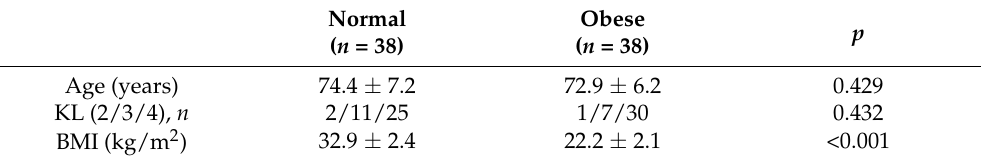
Figure 1. Expression of CPA3 and NMU / NMURs in the synovial membrane of normal-weight, overweight, and obese groups. The expression of NMU / NMURs and CPA3 mRNA in NW, OW, and OB groups was estimated by qPCR ( A – D ). NMU ( A ), NMUR1 ( B ), NMUR2 ( C ), and CPA3 ( D ) mRNA expression in the synovial membrane of normal-weight (NW, n = 79), overweight (OW, n = 87), and obese (OB, n = 40) patients with knee osteoarthritis. Gene expression is presented in box and whisker plots, showing the median, 25th, and 75th percentiles and range. * p < 0.05. Table 2. Clinical characteristics after propensity score